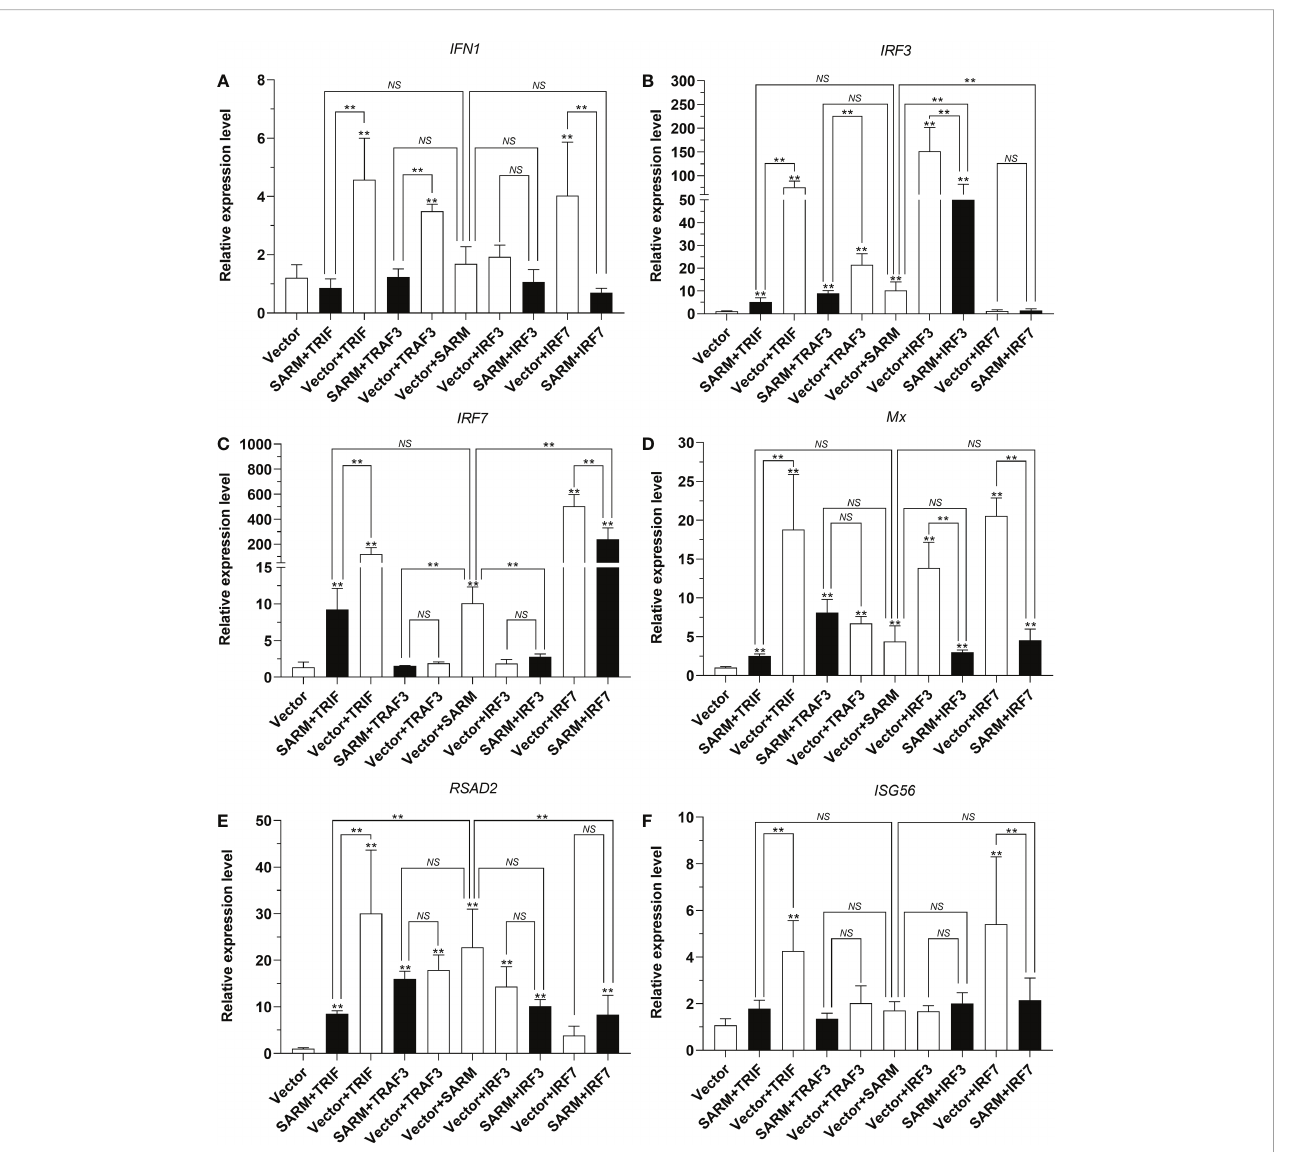
FIGURE 12 Association of Lc -SARM with Lc -TRIF, Lc -TRAF3, Lc -IRF3, and Lc -IRF7 in the induction of antiviral-related genes expression. LYCMS cells seeded on 6- well plates at a density of 4 × 10 5 cells per well were co-transfected with 2.5 m g of pcDNA3.1-SARM together with 2.5 m g of pcDNA3.1-TRIF, pcDNA3.1- TRAF3, pcDNA3.1-IRF3, or pcDNA3.1-IRF7 alone or in a combination of two, with the total amount of transfected plasmids balanced with the pcDNA3.1 empty vector. At 48 hpt, the cells were collected to extract total RNA for evaluating the mRNA expression levels of antiviral-related genes including IFN1 (A) , IRF3 (B) , IRF7 (C) , Mx (D) , RSAD2 (E) , and ISG56 (F) by qRT-PCR analysis. The results were calculated by normalization to the expression of L. crocea b -actin and then recorded as fold change compared to the control group. All data are expressed as the mean of three individual experiments, with